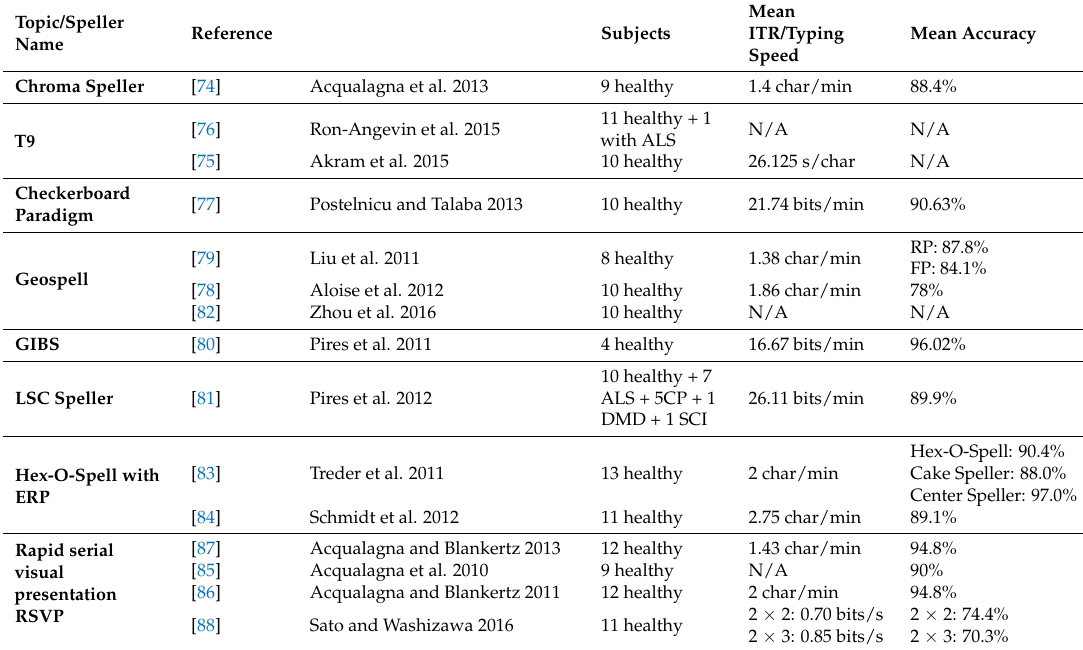
Table 3. Summary of all other P300-based spellers which are not directly related to the Matrix Speller.